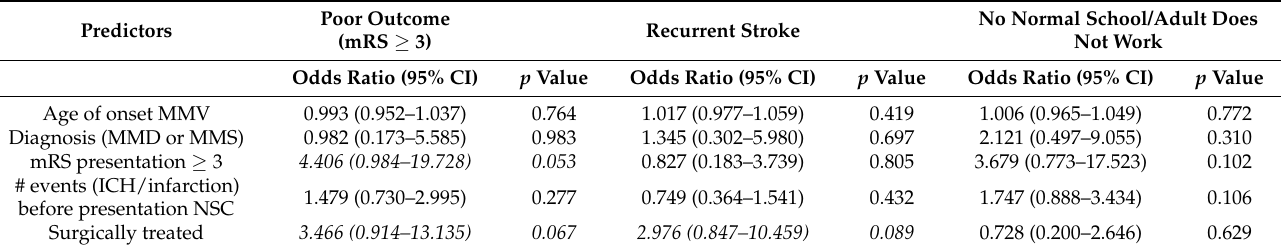
Table 3. Multivariable logistic regression